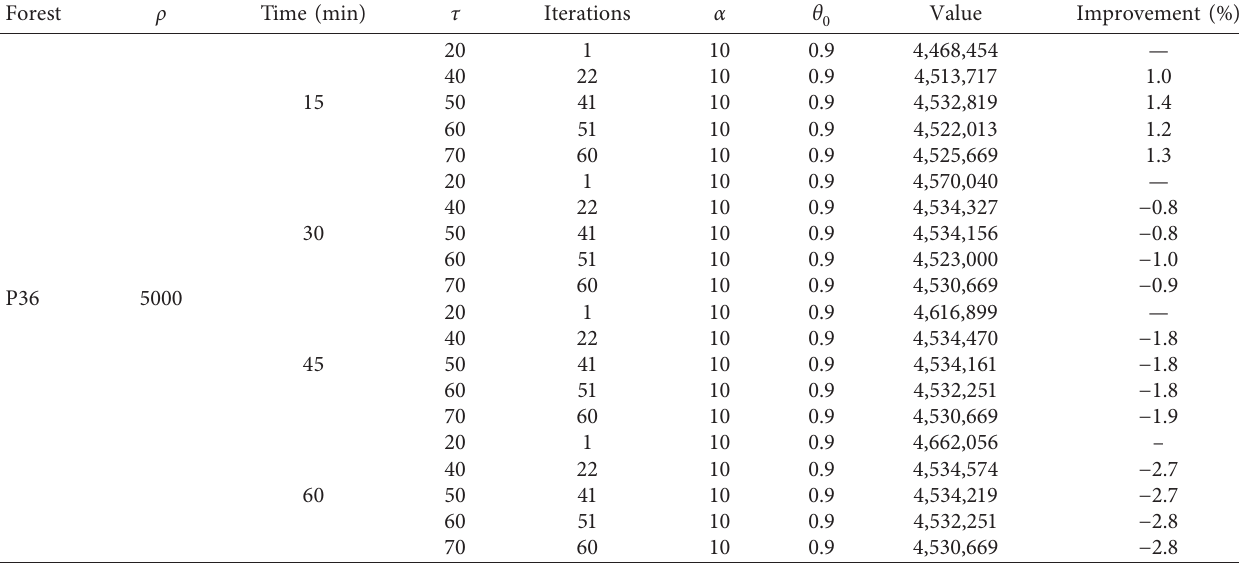
Table 6: Effects of τ and allocated time for the forest P36.